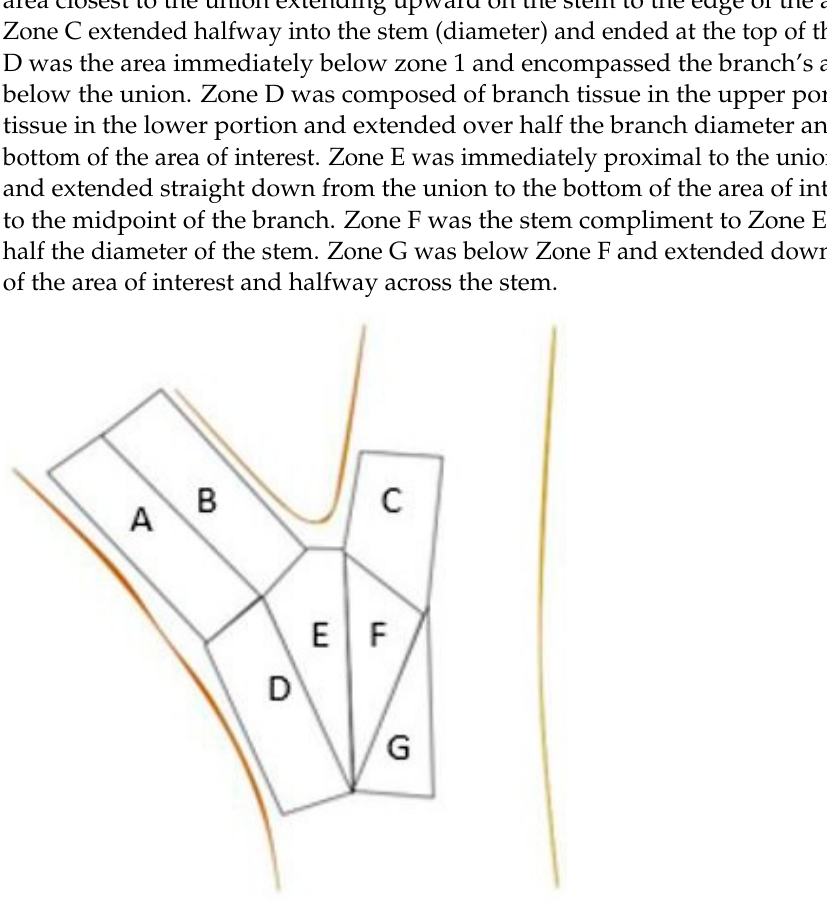
Figure 3. Schematic of branch union with the seven zones (A-G) utilized for strain distribution. Branch attachment angle was measured with the DIC system by placing a reference point in the union where the branch appeared to have originated (Figure 2B). Two vectors from this reference point were then defined by placing an endpoint on the branch well above the union and an end point on the stem. The subsequent angle between the two